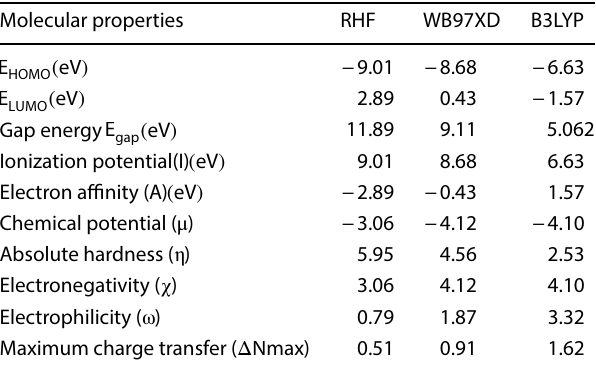
Table 5 Overall reactivity indices of andirobin obtained by RHF, wB97XD and B3LYP methods with 6–311 G(d,p) basis set